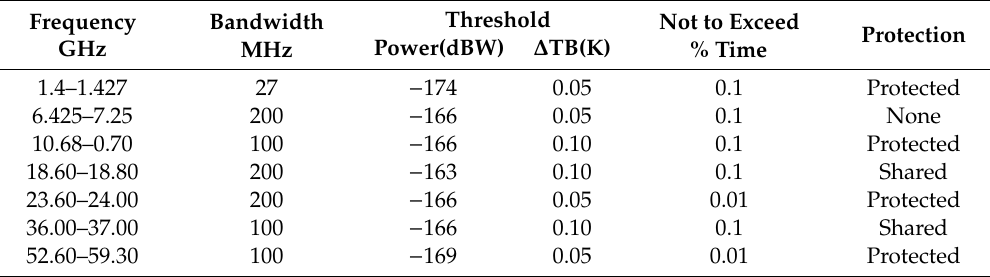
Table A1. Protection levels for frequency bands allocated to passive microwave remote